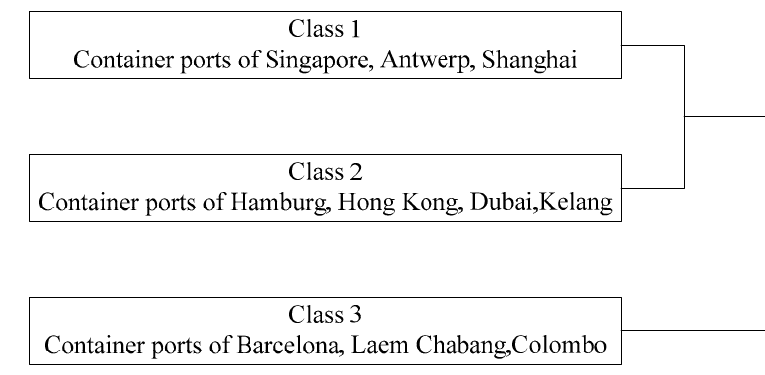
Figure 2. Comparison of the operational efficiency (CCR-DEA) and the environmental performance (SBM-DEA) of the 10 container ports along the MSR.